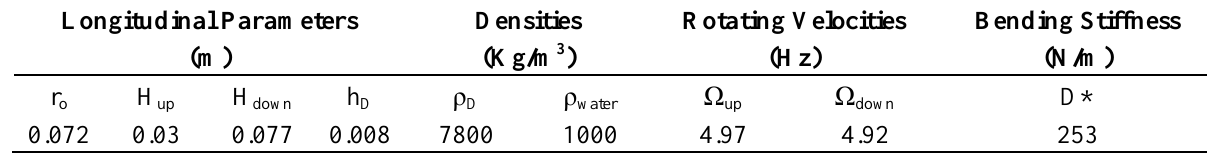
Table 1. Parameters used to determine the natural frequencies of the rotating disk in air and in water ( = 8 Hz) for each disk